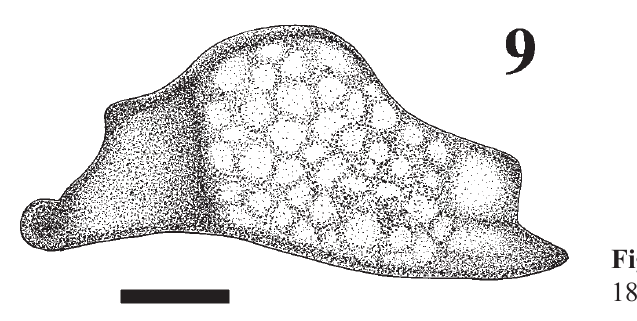
Fig. 9. Mandible of Sharon amoenus (Philippi, 1861) comb. nov. scale bar = 0.5